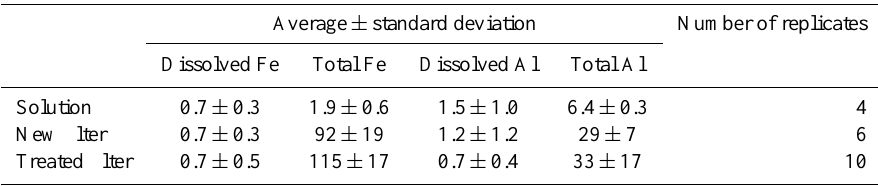
Table 1. Average concentration and standard deviation of the Fe and Al concentrations (unit: µgł − 1 ) in the extraction solutions (ammonium acetate and 1 M HNO 3 ) , new filter blanks, and “treated filter blanks” measured using